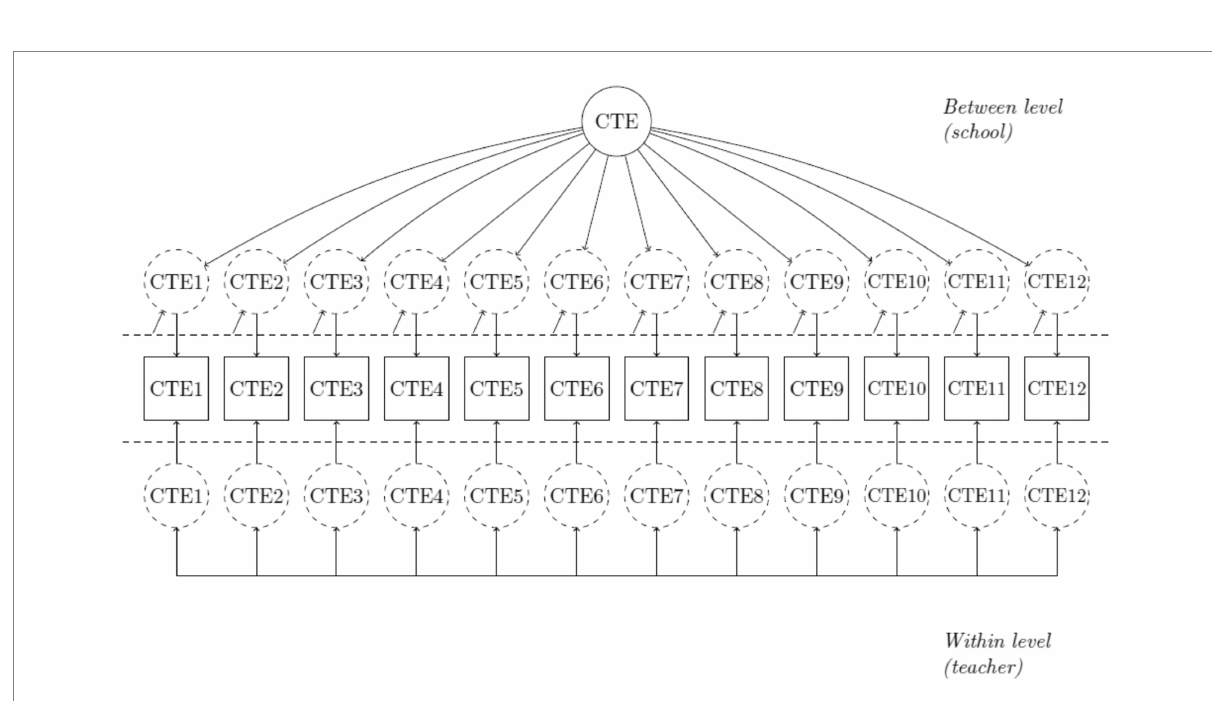
FIGURE 2 Single-factor measurement model (Single school-level shared construct). CTE = collective teacher